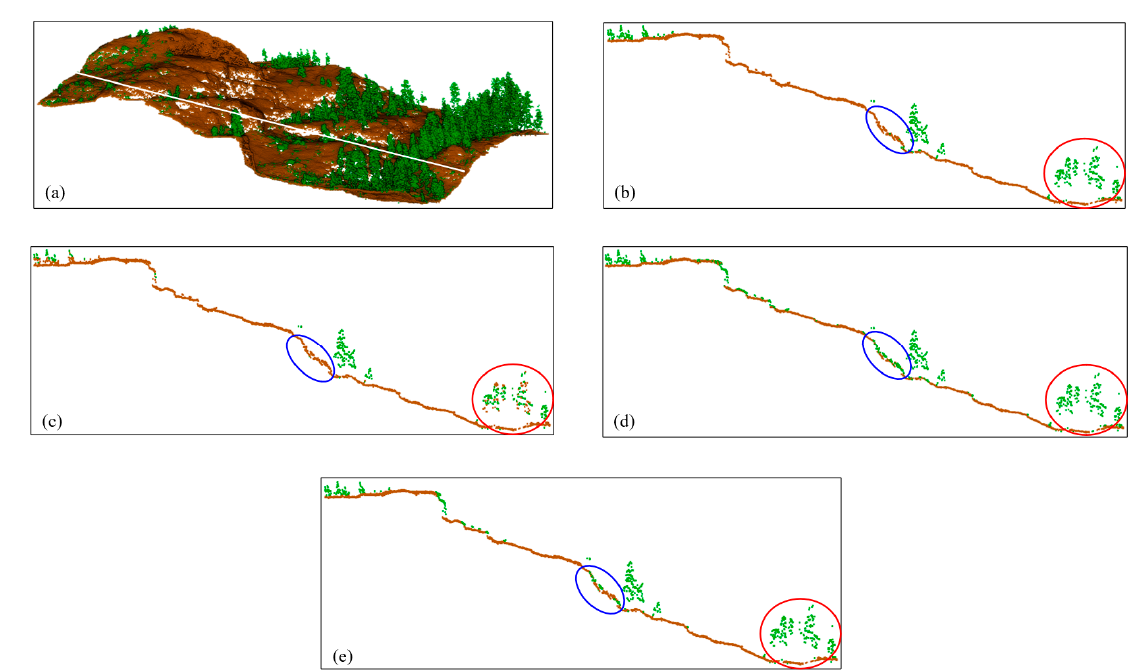
Figure 12. Validation results for the contribution in the ground point extraction step. ( a ) The 3D transect position (white line) in Site 4. The 3D transects of ground filtering results obtained by ( b ) human interaction and the methods ( c ) without incorrect ground point elimination and adaptive terrain reconstruction, ( d ) with incorrect ground point elimination, and ( e ) with incorrect ground point elimination and adaptive terrain reconstruction. Ground points were extracted more accurately after incorrect ground point elimination, and the adaptive terrain reconstruction could further improve the accuracy of ground filtering on steep slopes. The content inside the ellipses indicates typical filtering